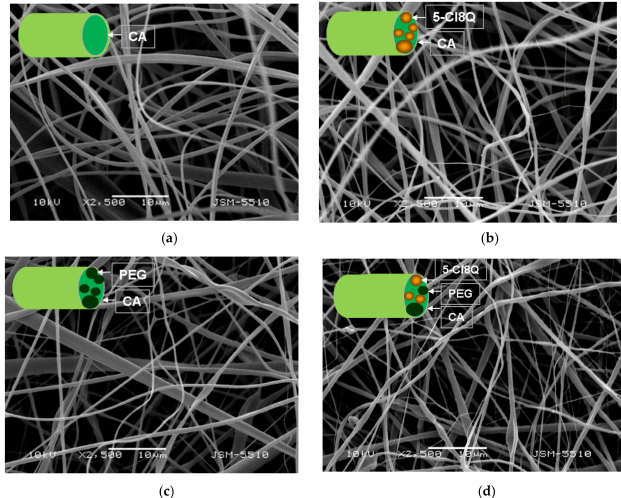
Figure 1. SEM micrographs and schematic representation of the cross-section of fibers (insets) of electrospun membranes of cellulose acetate (CA) ( a ), CA / 5-chloro-8-hydroxyquinolinol (5-Cl8Q) ( b ), CA / polyethylene glycol (PEG) ( c ) and CA / PEG / 5-Cl8Q ( d ); magnification ×